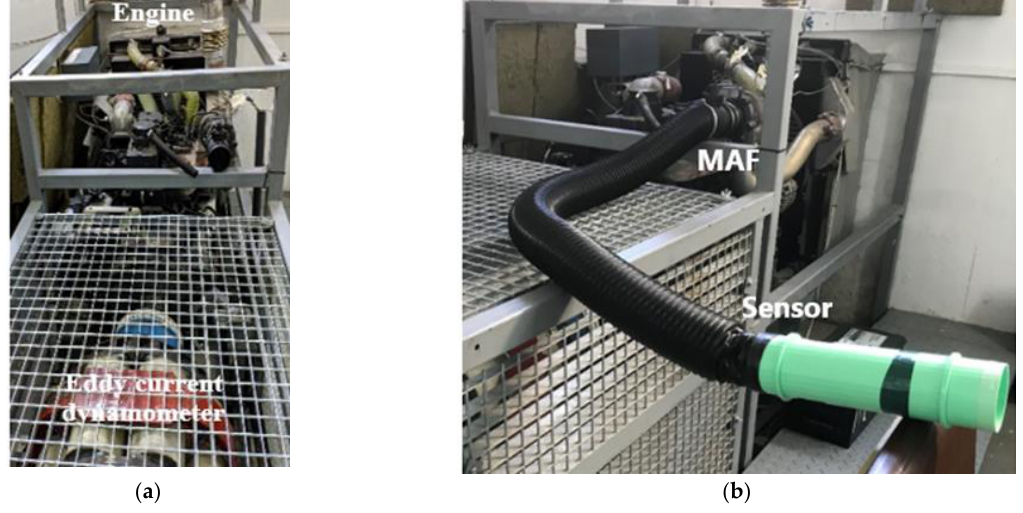
Figure 10. ( a ) Engine testbed experimental setup; ( b ) the developed sensor mounted in series with the integrated MAF of the testbed .